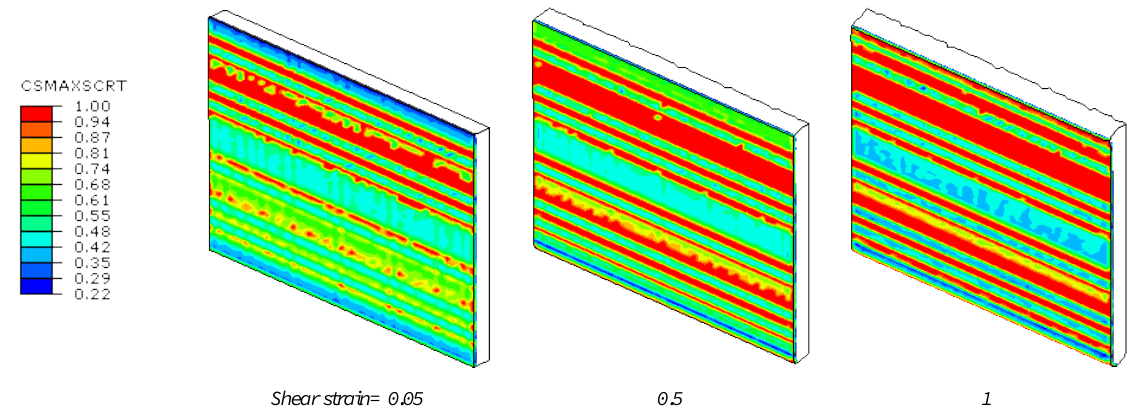
Fig. 10 Evolution of plastic yielding in the M0C model (ABAQUS, 1/4 specimen), with δ f =1.5mm and t 0 =8MPa the CZM input. In evidence, the adhesive